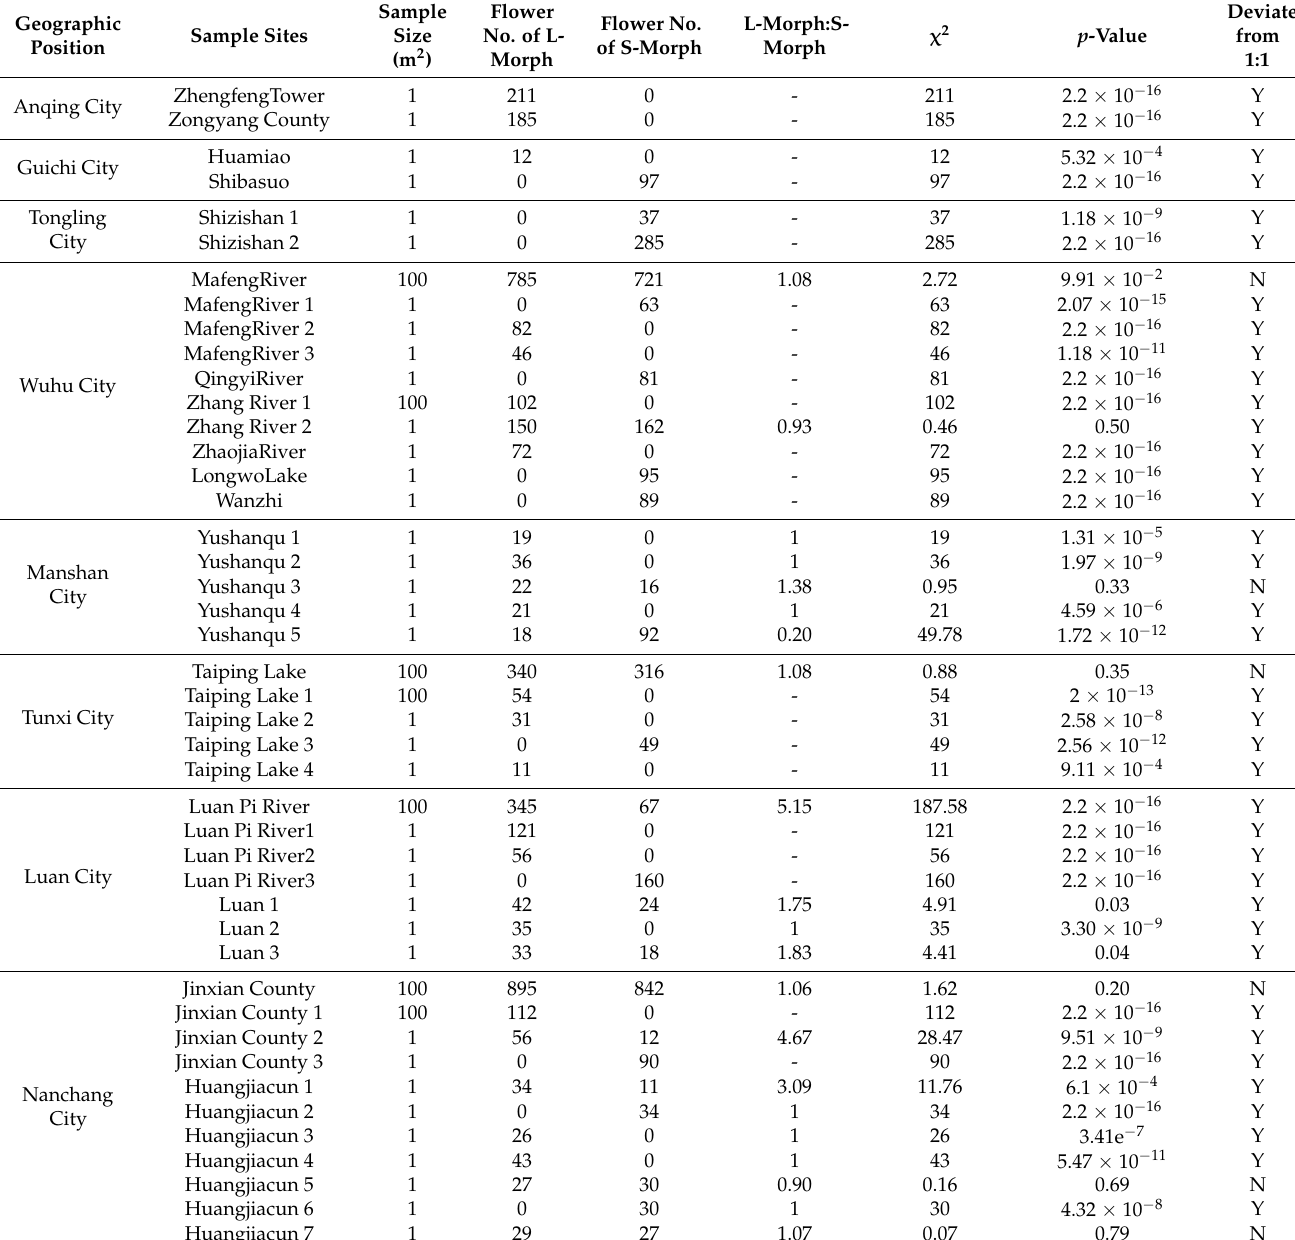
Table 2. Style-morph ratios in 44 natural populations of P. criopolitanum